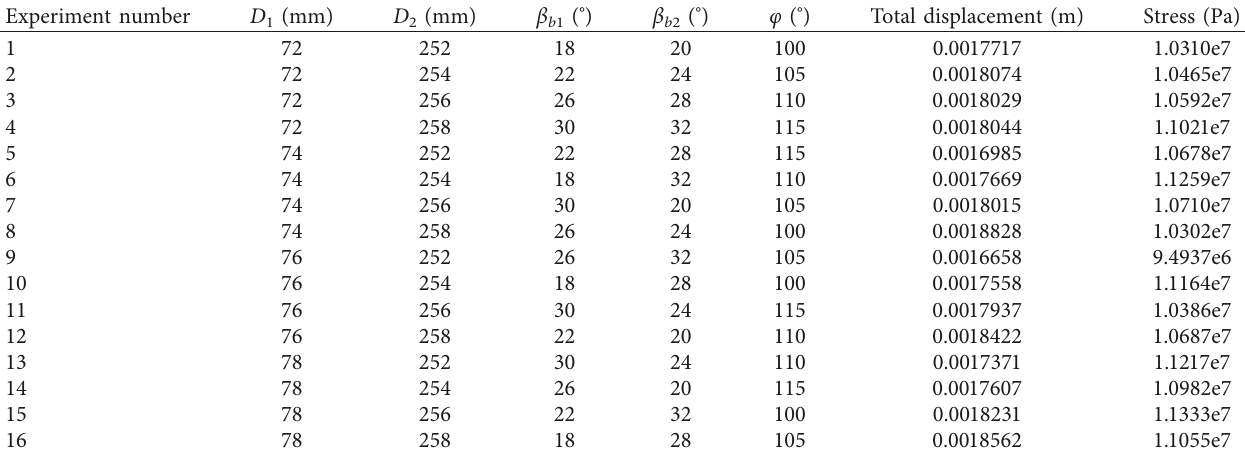
Table 7: Orthogonal experimental table of flow thermal and solid coupling of pump.